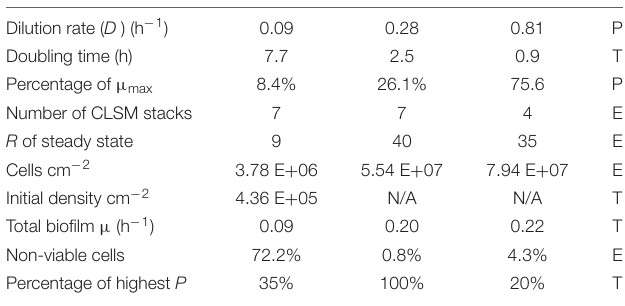
TABLE 3 | Parameters (P), experimental (E), and theoretical (T) values for the chemostat culture of E. faecalis